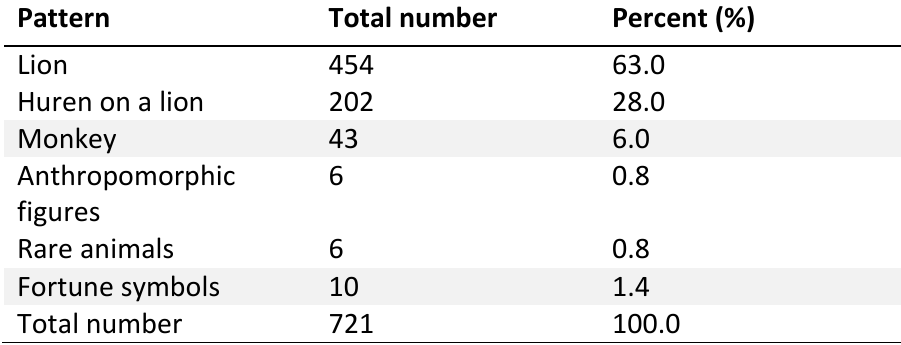
Table 2. Proportion of different patterns in Chengcheng county